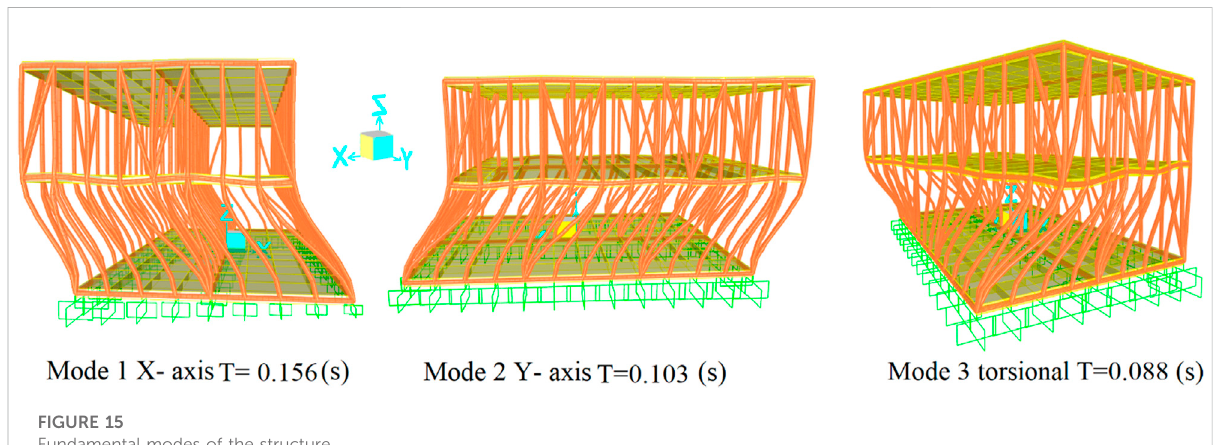
FIGURE 15 Fundamental modes of the structure.